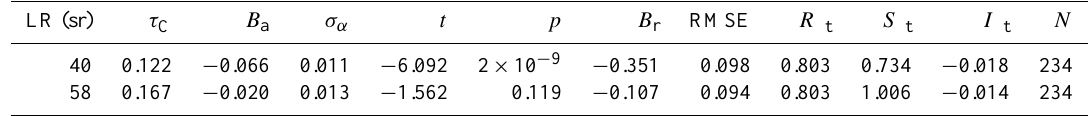
Table 2. Statistical indicators for CALIPSO and MODIS comparisons under different LR assumption for CALIOP (40sr vs. 58sr). Average